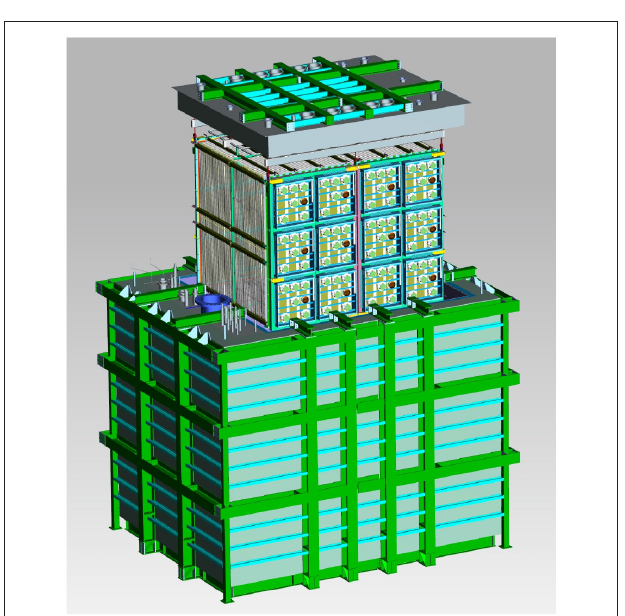
FIGURE 2 | Engineering diagram of the SBND LArTPC and its surrounding subsystems. Here, the TPC is shown lifted above the cryostat for